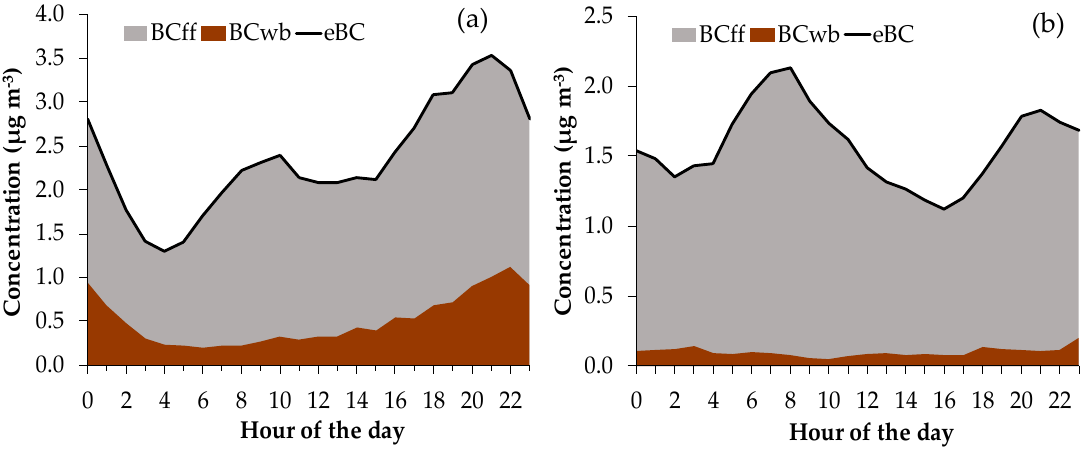
Figure 4. Mean diurnal variability of eBC, BC wb and BC ff concentrations during ( a ) the cold and ( b ) the warm period.